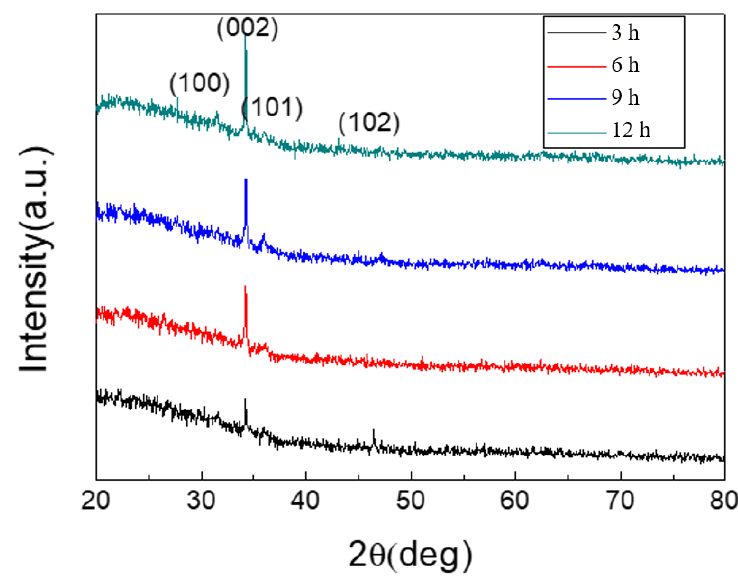
Figure 5. XRD patterns of zinc oxide nanostructures at different growth times.